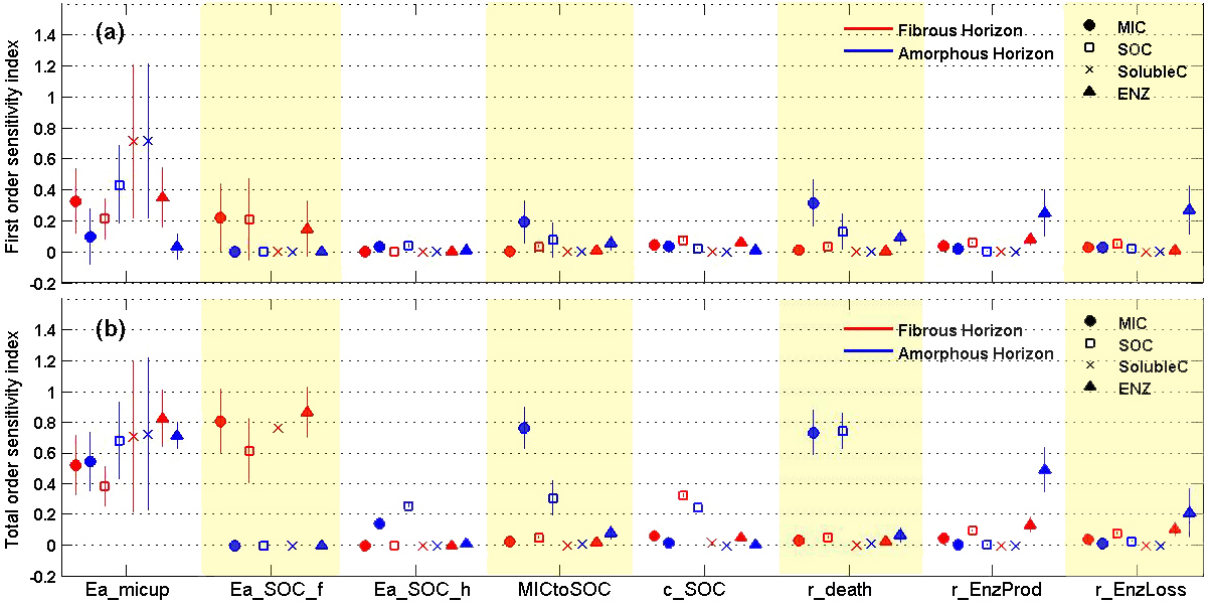
Figure 6. Sobol’s estimates of first (a) and total-order (b) parameter sensitivity indices of microbial biomass (MIC), soil organic C (SOC), soluble C (SolubleC), and enzyme (ENZ) pools with their 95% confidence intervals (vertical lines) under standard soil temperature and moisture (STDt and STDm). 8 out of 10 selected parameters are presented here because the other 2 (Litter_NPPfrac and Vmax_SOC0_f) did not show significant sensitivity (sensitivity indices < 0.1).